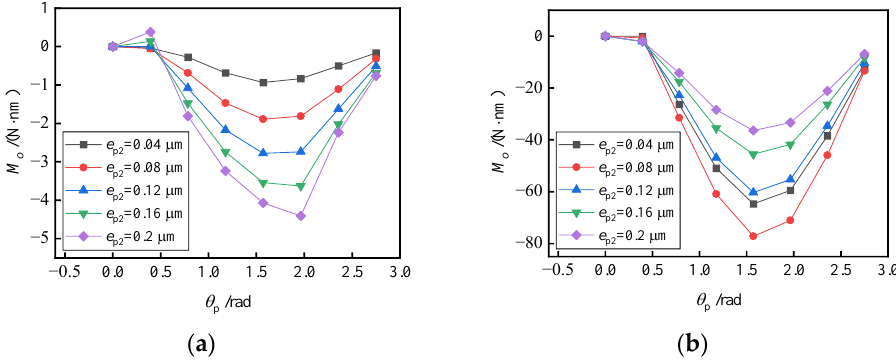
Figure 12. Interference torque versus oval error. ( a ) with grooves ( b ) without grooves.